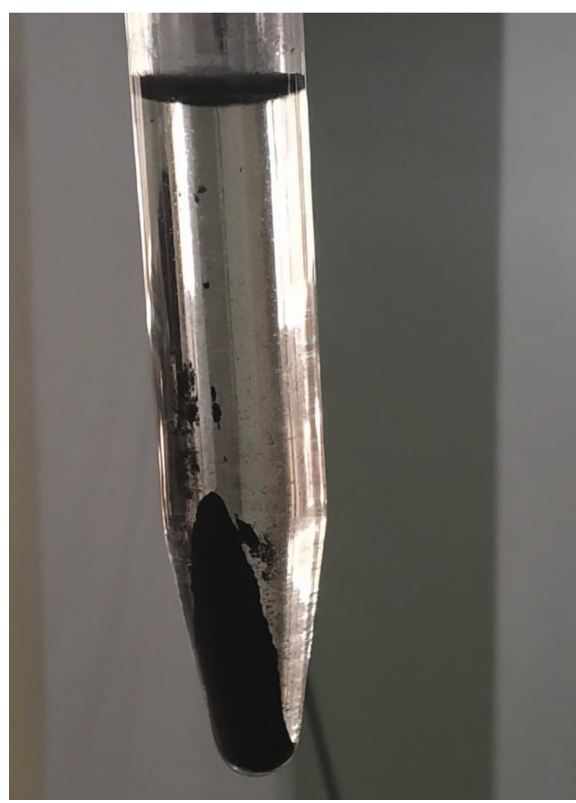
Figure 5: Centrifugation at 1500rpm for 20 minutes.